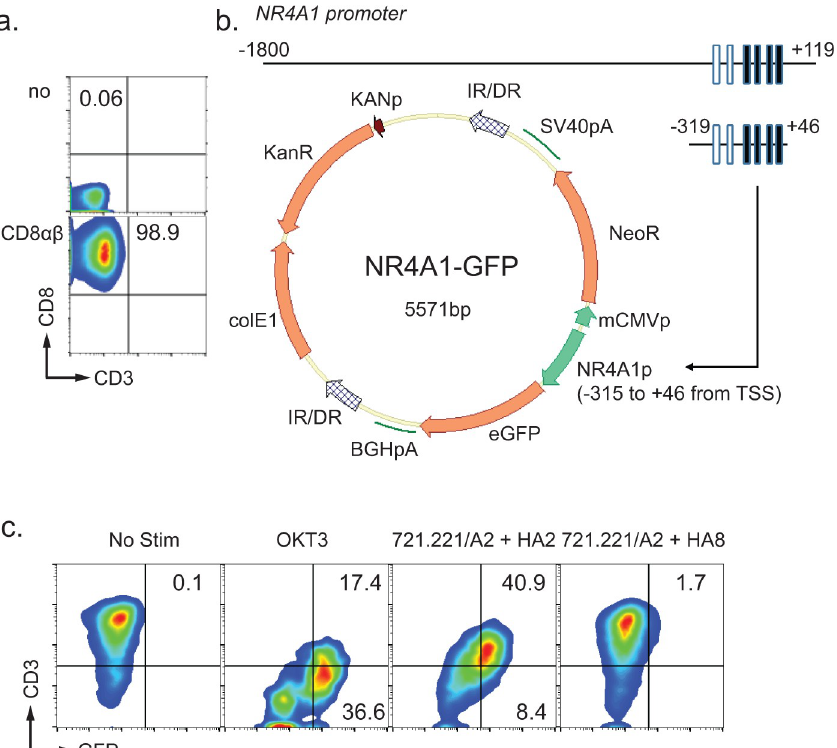
Fig 2. Generation of the JRFTCR. a. Introduction of the CD8 αβ heterodimer. The SB system was used to introduce CD8 αβ into the Jurkat 76 cell line. Data are the CD8 expression levels in isolated clones. b. The top panel shows the NR4A1 promoter. Closed boxes represent cAMP response element binding protein (CREB) response elements; open boxes represent myocyte enhancer factor-2 (MEF2) response elements. The bottom panel shows the plasmid map for the reporter construct. An SB DNA plasmid carrying a bi-directional promoter (NR4A1 and a minimal CMV promoter) was generated as shown. IR/DR, inverted repeat; NeoR, neomycin resistant gene; eGFP, enhanced GFP. c. Reporter assay using JRFTCRs transduced with HA2/HLA-A2 − specific TCR αβ genes. The JRFTCRs were stimulated with HLA-A2 − transduced 721.221 cells pulsed with either a cognate HA2 peptide (YIGEVLVSV) or an irrelevant HA8 peptide (RTLDKVLEV) [27]. Numbers indicate the percentages of GFP +